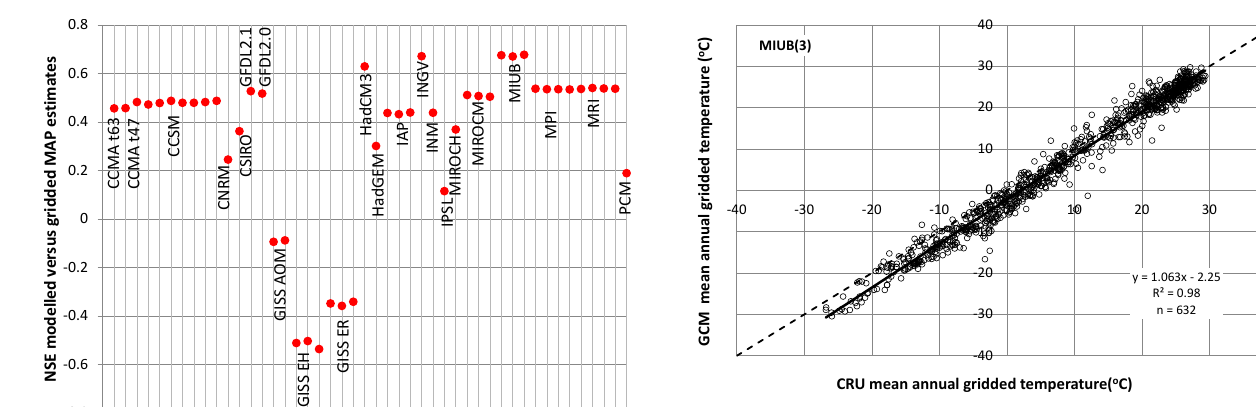
Figure 3. Nash–Sutcliffe efficiency (NSE) values for modelled ver- sus observed MAP untransformed estimates for 46 CMIP3 GCM runs.